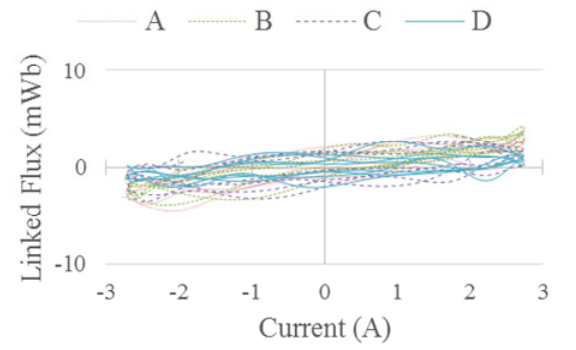
Fig. 6. Characteristic of the linked flux as function of line current during the normal operation regime.